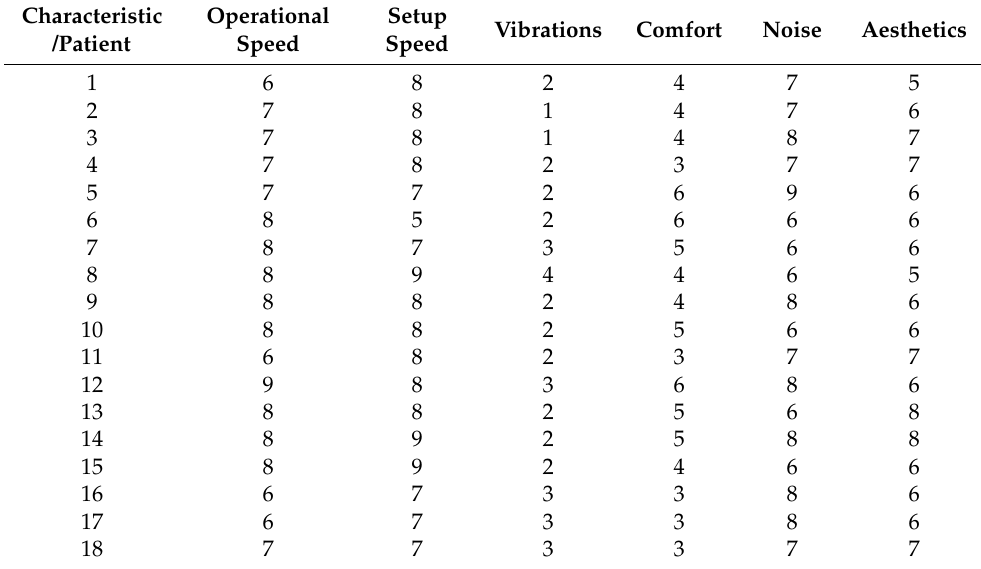
Table 3. Adduction/abduction